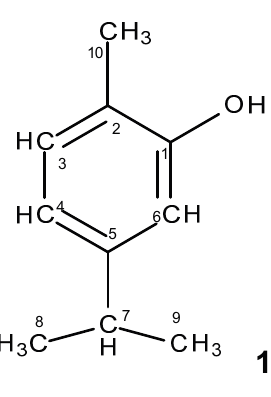
Figure 1. Structure of carvacrol ( 1 ) and chalepensin ( 2